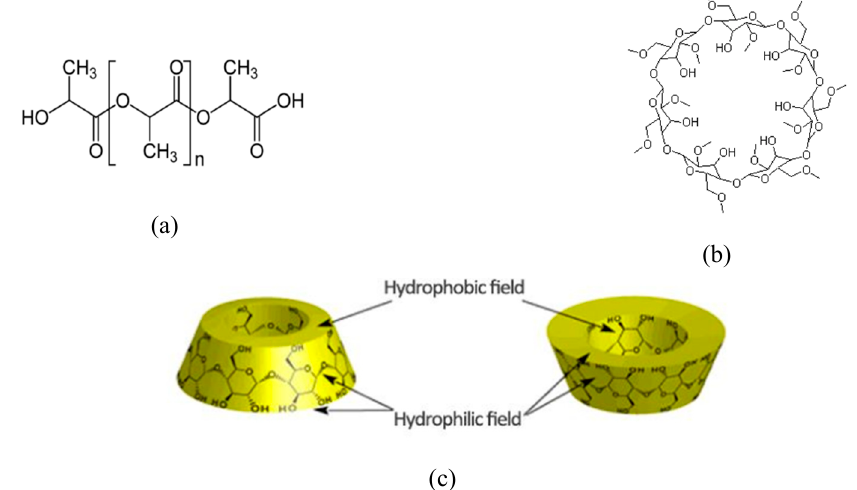
Figure 1. ( a ) poly(lactic acid) (PLA) chemical structure; ( b ) cyclodextrin (CyD) chemical structure; and ( c ) representation of CyD structure.